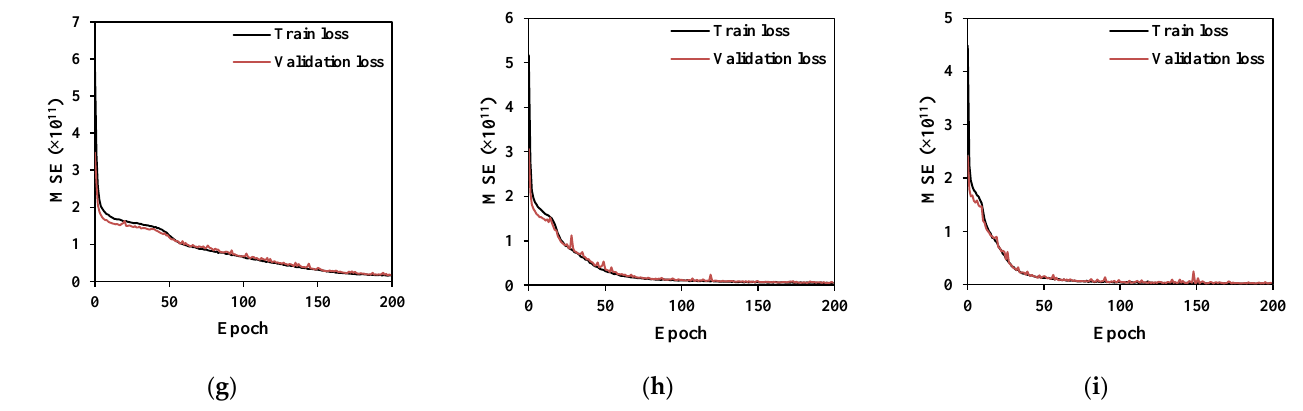
Figure 9. Comparisons of training and validation loss of bracing moments ( 𝑀 𝑏𝑟,𝑚𝑎𝑥 , 𝑀 𝑏𝑟,𝑚𝑖𝑛 ): ( a ) 3- 50-200; ( b ) 3-100-200; ( c ) 3-200-200; ( d ) 4-50-200; ( e ) 4-100-200; ( f ) 4-200-200; ( g ) 5-50-200; ( h ) 5-100-200; and ( i ) 5-200-200 (in which 3-50-200 means a DNN model with three hidden layers, 50 neurons for each hidden layer, and 200 epochs). Table 9. Accuracy of DNN models for 𝑀 𝑏𝑟 using various performance criteria.